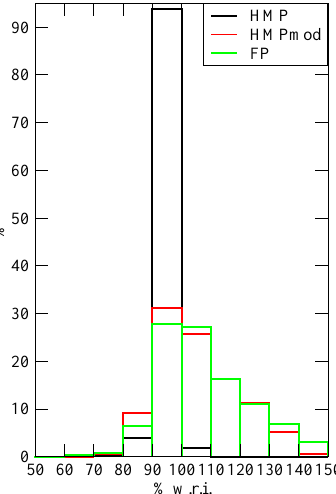
Figure 9. Same as Fig. 6 but for moisture partial pressure above 2Pa